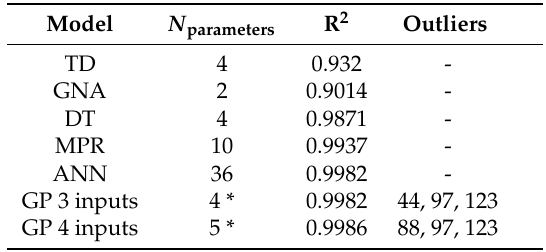
Table 3. Model performance for the absorption machine. TD, thermodynamic model; GNA, adapted Gordon–Ng; MPR, multivariate polynomial regression; ANN, Artificial neural networks.